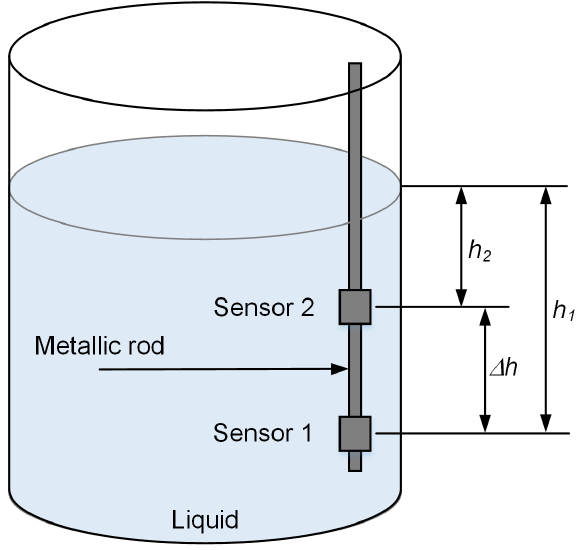
Figure 1. Differential pressure measurement in a liquid